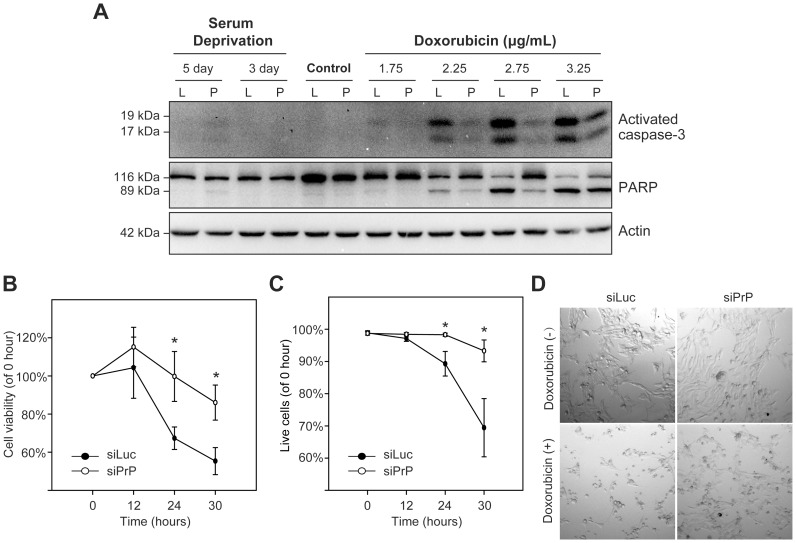
The influence of PrP knockdown on serum deprivation and doxorubicin-induced cytotoxicity.(A) Immunoblot analysis of activated caspase-3 and PARP cleavage in siPrP (P) or siLuc (L) cells subjected to serum deprivation for indicated time or doxorubicin treatment for 24 hours at indicated concentrations. Equal loading was verified by immunoblot analysis with an anti-actin antibody. Control, no treatment; L, siLuc cell line; P, siPrP cell line. (B) Results of MTT assay showing cell viability after incubation with 1.25 µg/mL doxorubicin for indicated time. (C) Live/dead cell number ratio determined by trypan blue exclusion assay after incubation with 1.25 µg/mL doxorubicin for indicated time. Asterisks represent statistically significant differences, which were determined by student's t test and indicated by * P<0.05. (D) Representative images of siLuc or siPrP cells incubated without or with 1.25 µg/mL doxorubicin for 30 hours.